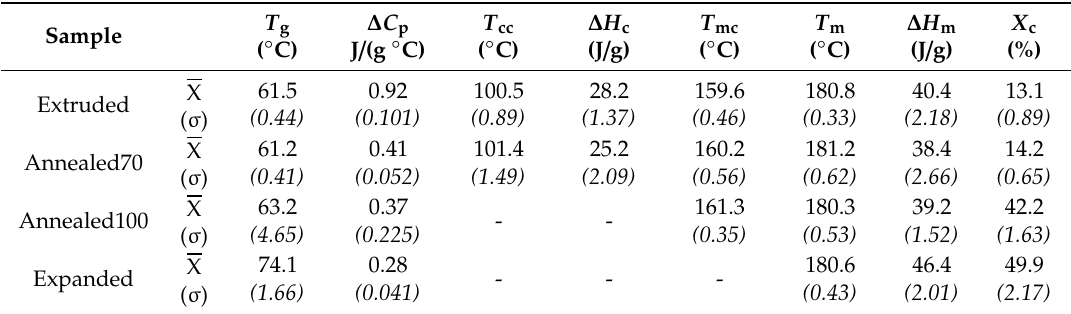
Table 1. Summary of the thermal properties and degree of crystallinity from each group, included are T g (glass transition temperature), ∆ C p (specific heat change), T cc (cold crystallisation), ∆ H c (enthalpy of cold crystallisation), T mc (melting recrystallisation), T m (melting temperature), ∆ H m (enthalpy of melting) and X c (degree of crystallinity).